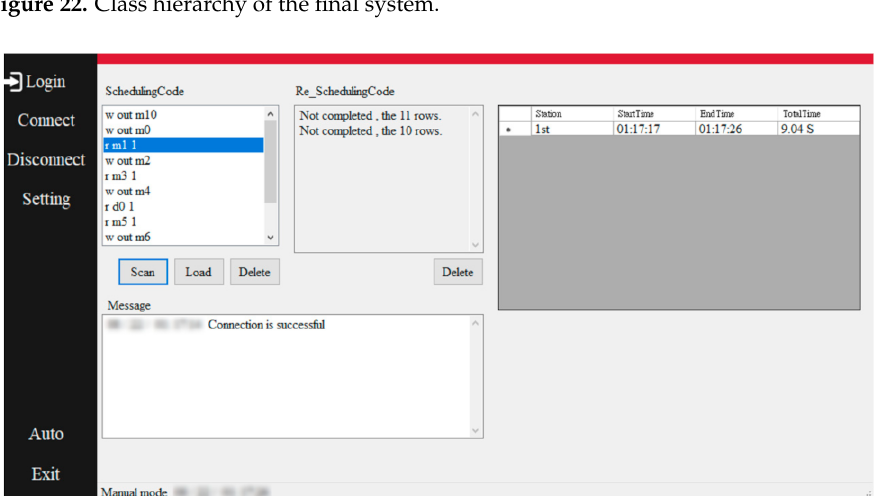
Figure 22. Class hierarchy of the final system.